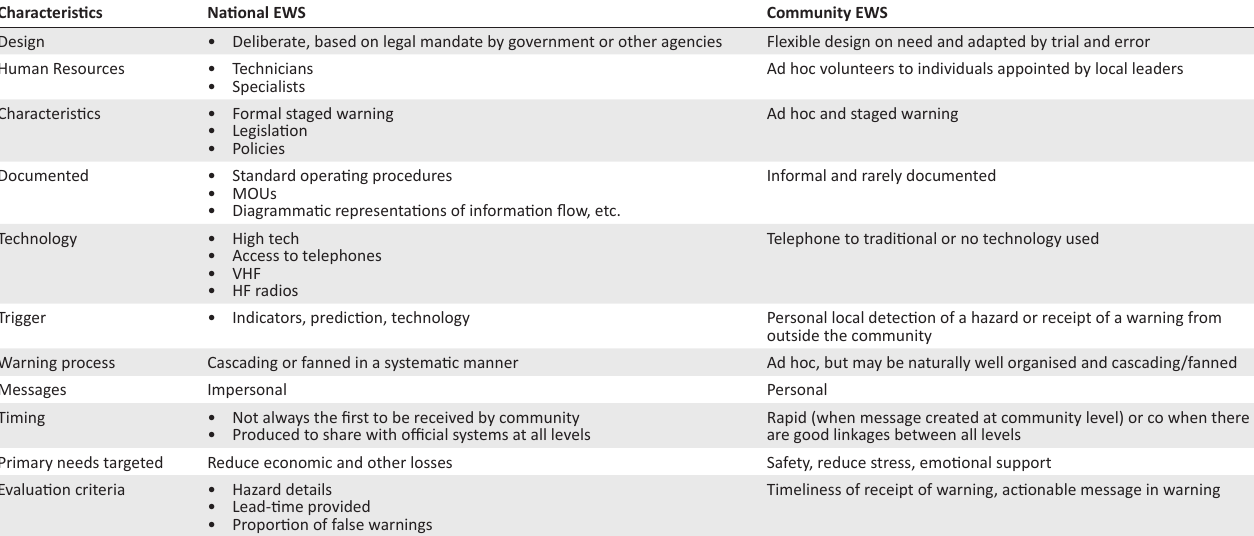
TABLE 1: Main characteristics of national early warning systems and community early warning systems. Characteristics National EWS Community EWS